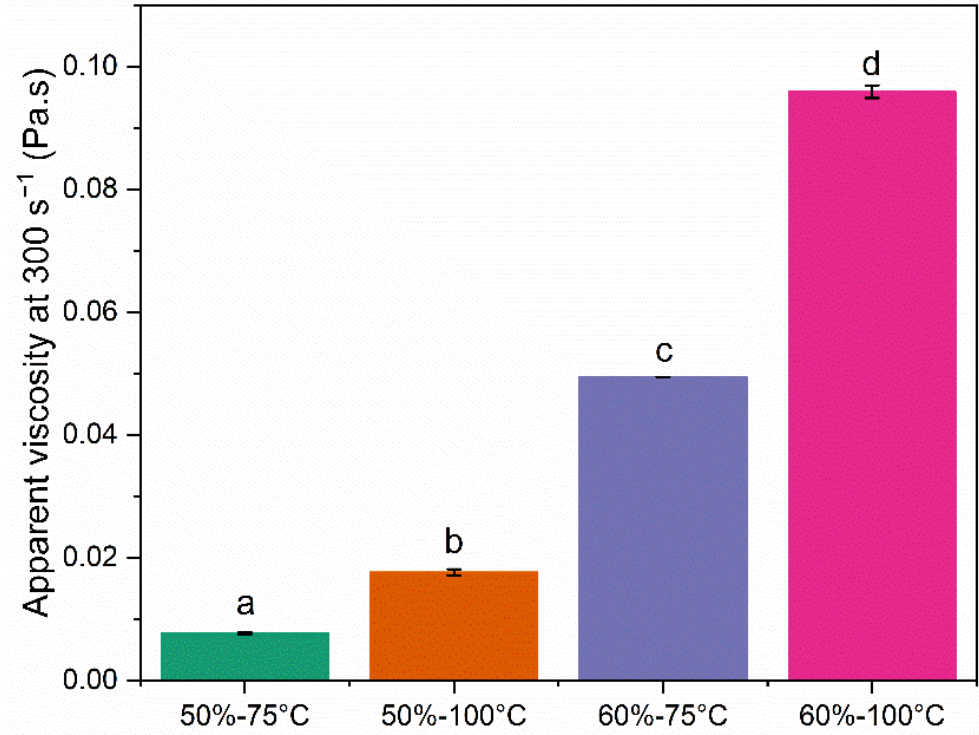
Figure 2. Apparent viscosity of the emulsion feed, determined at 300 s − 1 . Bars indicate the standard deviation ( n = 4).